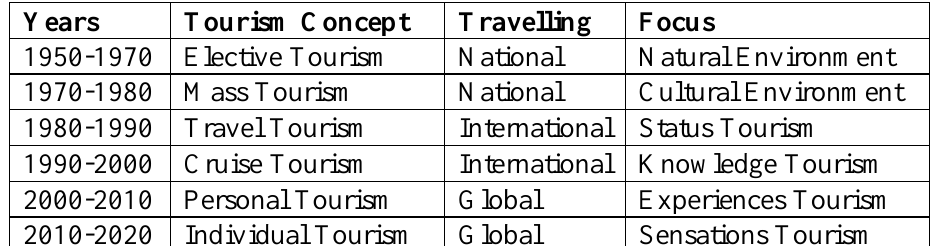
Figure 1: The Role of Tourism in Affluent